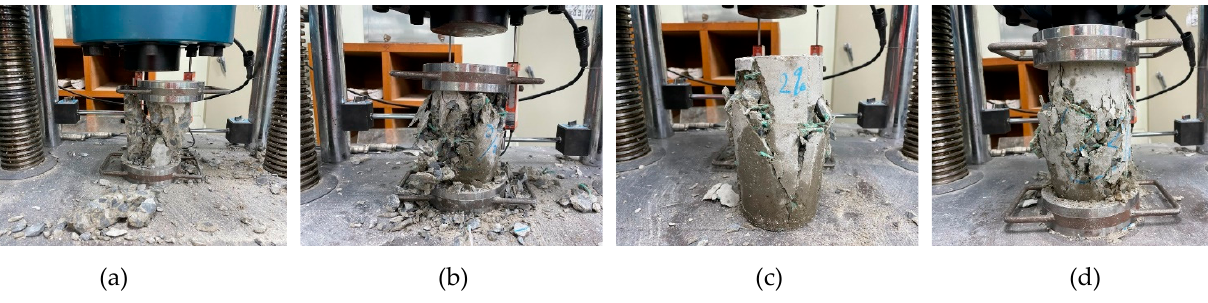
Figure 5. Average compressive strength results: ( a ) Constitutive curves; ( b ) compressive strength results.